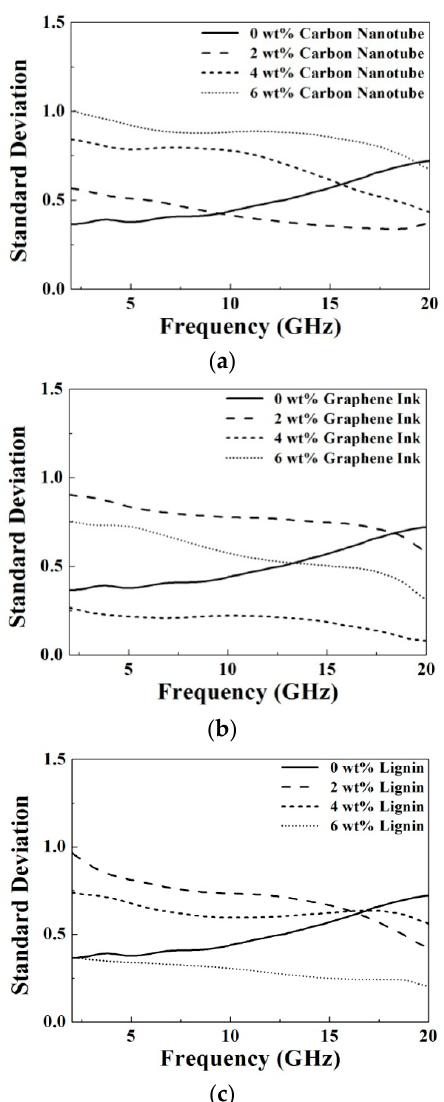
Figure 5. The calculated standard deviation of the measured dielectric constant for the prepared samples with different doping materials, including ( a ) carbon nanotube; ( b ) graphene ink and ( c ) lignin.